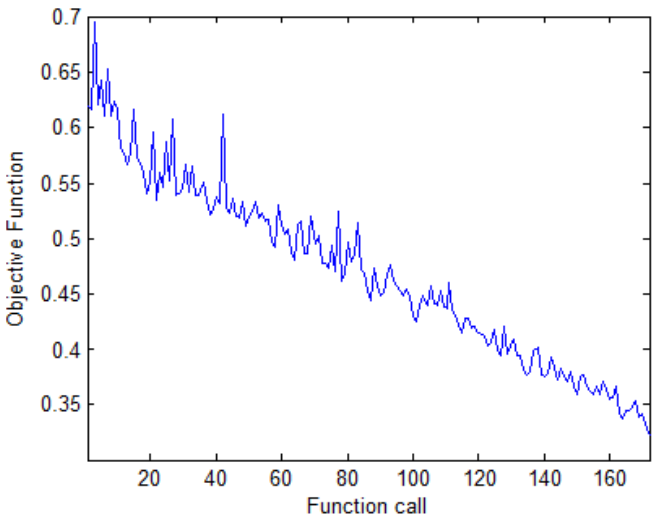
Figure 7. The objective function change during the optimization.